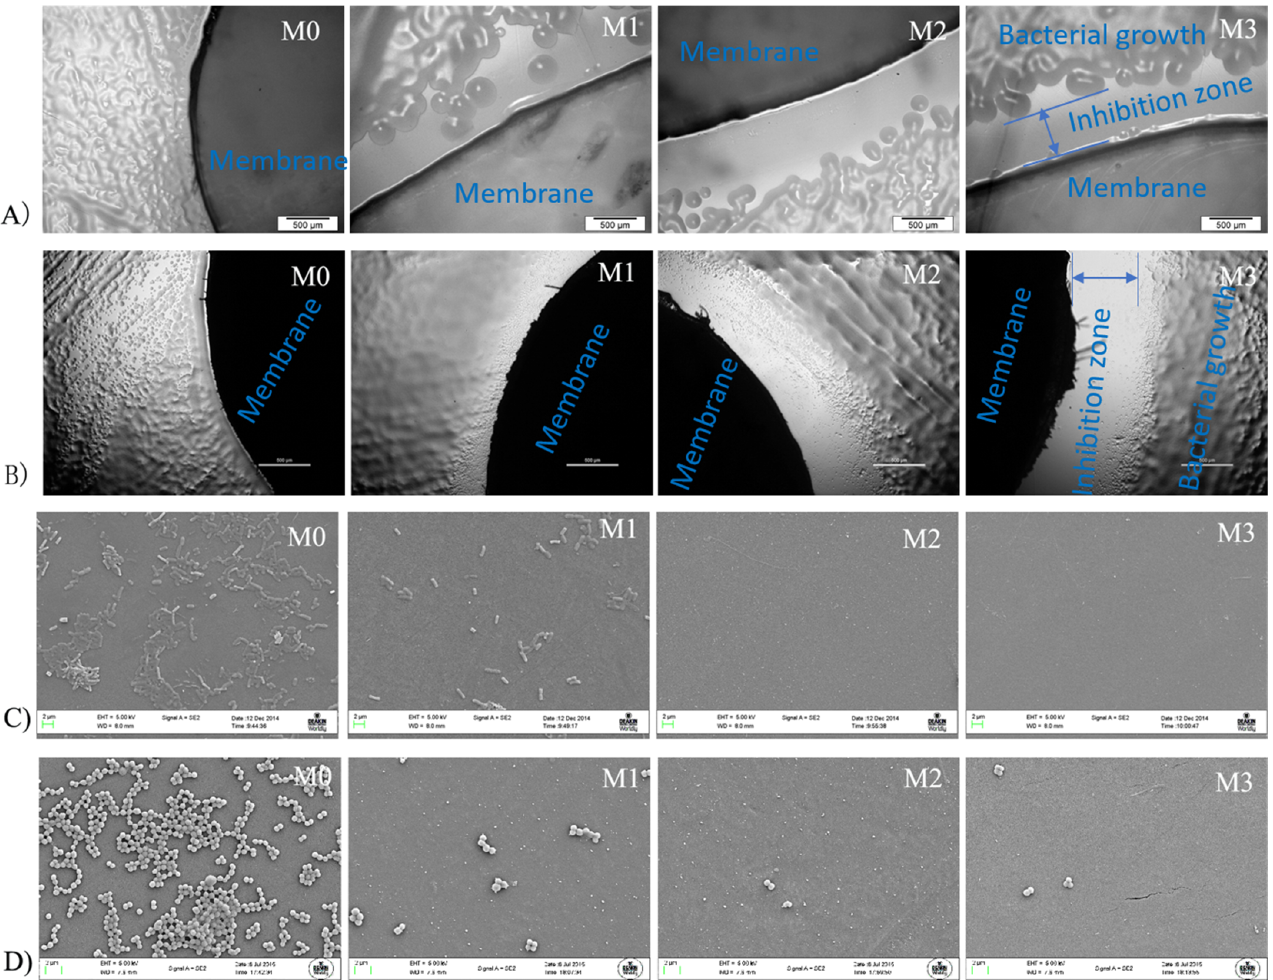
Figure 5. Antibacterial and anti-biofouling results of the membrane surfaces using the disc diffusion method against ( A ) E. coli and ( B ) S. aureus ; and biofilm formation test against ( C ) E. coli and ( D ) S. aureus